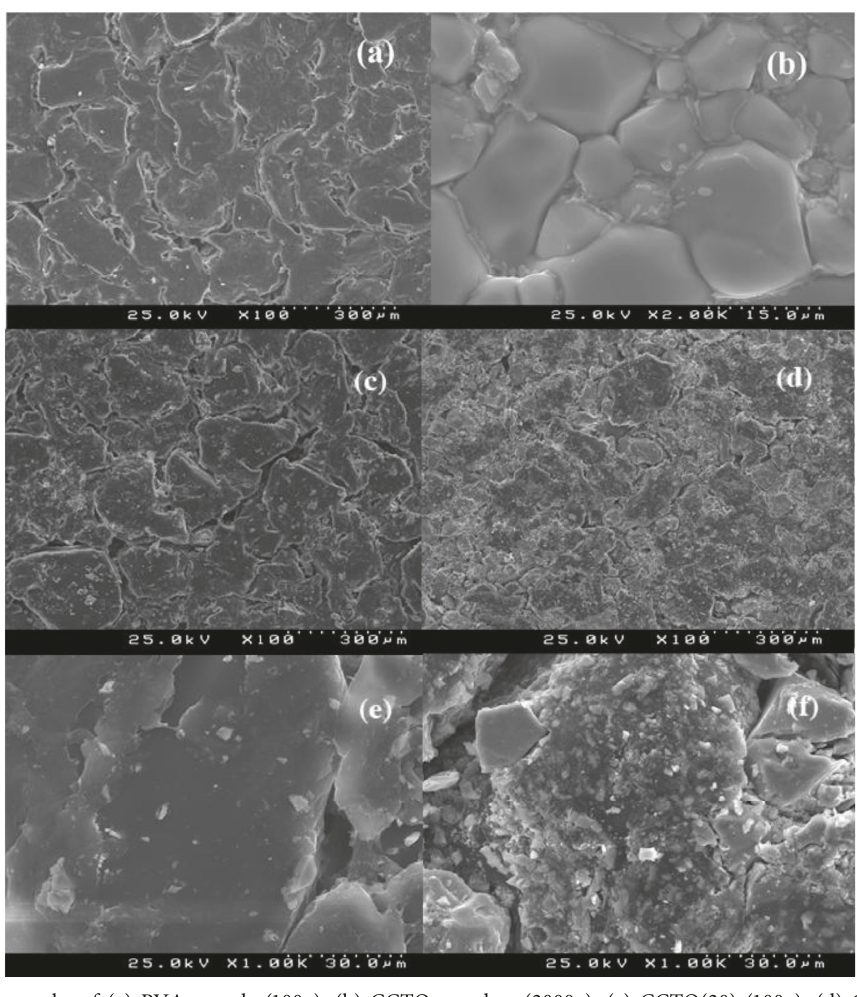
Figure 3: SEM micrographs of (a) PVA sample (100x), (b) CCTO powders (2000x), (c) CCTO(20) (100x), (d) CCTO(50) (100x), (e) CCTO(20) (1000x), and (f) CCTO(50) (1000x).